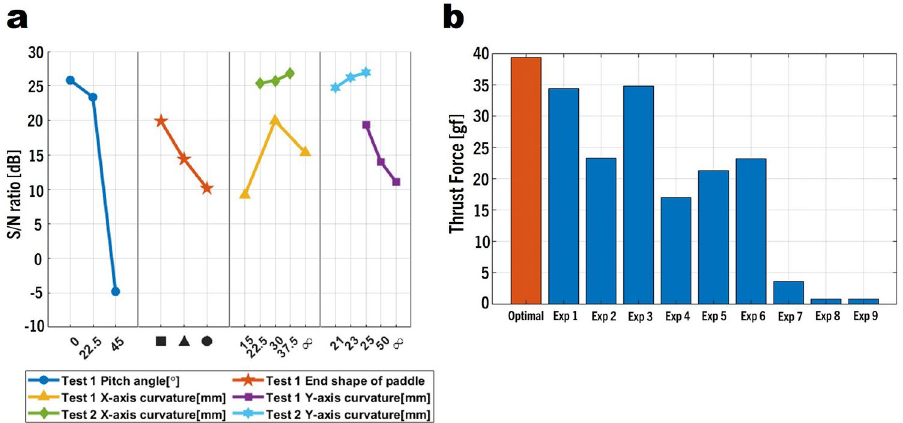
4 Figure 5. ( a ) Shows S/N ratio of L 9 ( 3 ) Taguchi orthogonal array. ( b ) Shows paddle performance comparison with optimal design parameters and other design parameters of the L9(34) orthogonal array. Exp 1 is the initial paddle design.